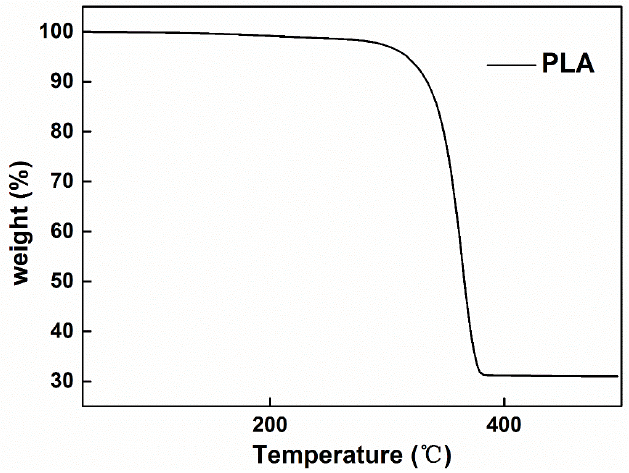
Figure 10. TGA patterns of PLA fibers.